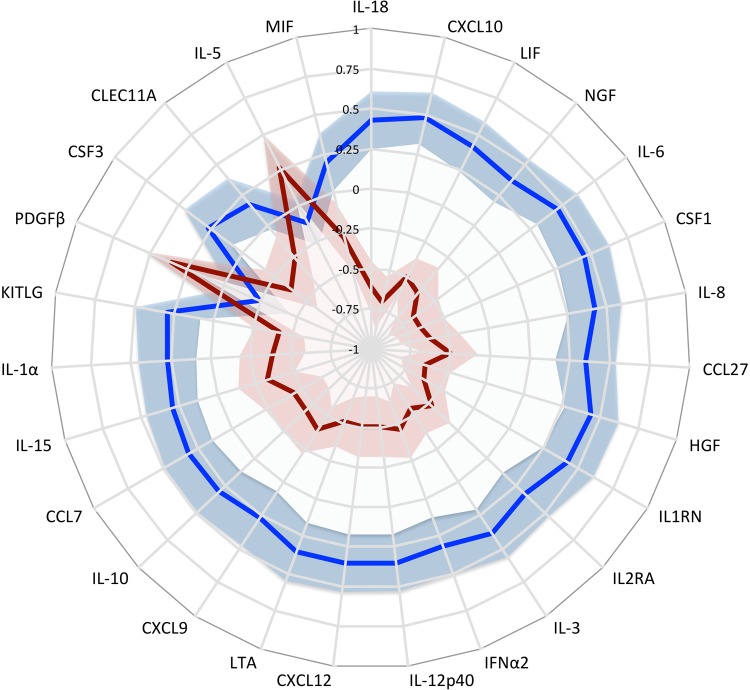
Serum cytokine changes in acute iNTS disease and in convalescence. Shown is a radar plot of the serum concentrations of cytokines (n = 27) significantly differentiated between acute iNTS disease (blue; n = 108) and convalescence (red; n = 75). Lower serum cytokine concentrations plot toward the center of the graph, and shaded areas represent 95% confidence intervals. Cytokine concentrations are normalized and standardized with rank-based inverse normal transformations.